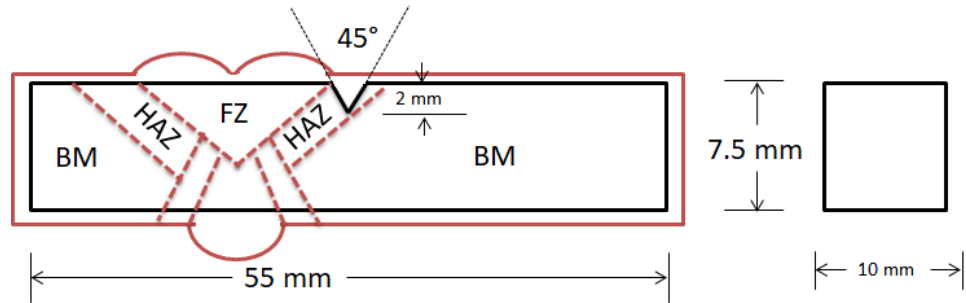
Figure 2. Schematic of V-notched Charpy specimen with sub-size dimensions as per ASTM E23-12c in black lines profile of the welded steel plate in red lines.